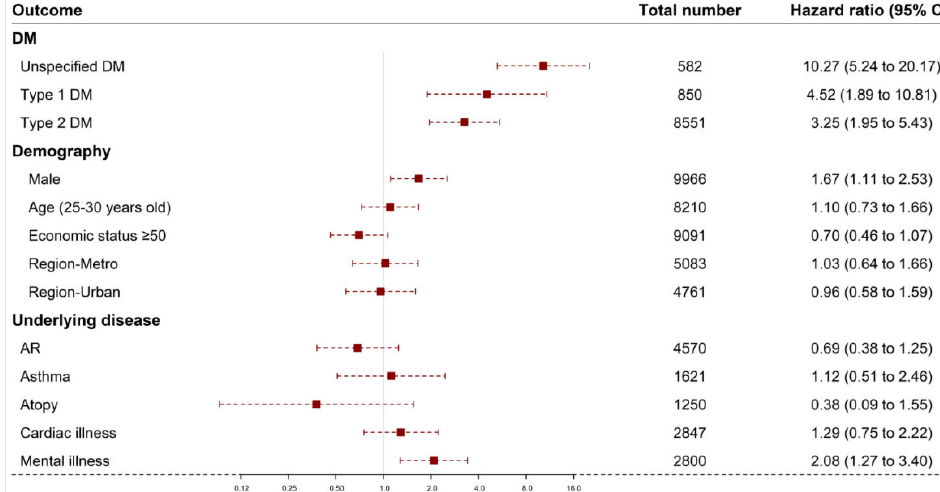
Figure 1. Hazard ratios and 95% confidence intervals for associations of prevalent diabetes and the number of deaths, by selected participant characteristics (DM type 1, 2 or unspecified, male, accompanied mental illness, age (25–30 years), economic status and residential area (metropolitan and urban)). Abbreviations: DM, diabetes mellitus, AR, allergic rhinitis. The red boxes indicate the hazard ratio and the horizontal lines extend from the lower limit to the upper limit of the 95 percent confidence